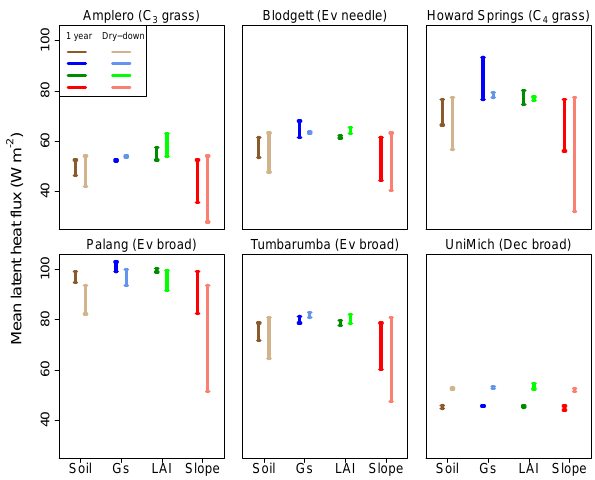
Figure 8. The range in simulated mean latent heat arising from the individual effects of soil (brown), g s (blue), LAI (green) and slope (red) parameterisations using the new hydrological scheme during the 1-year and dry-down periods. The individual effects were deter- mined by fixing the other parameterisations at their default values (medium soil, Medlyn g s , centre LAI and 0 ◦